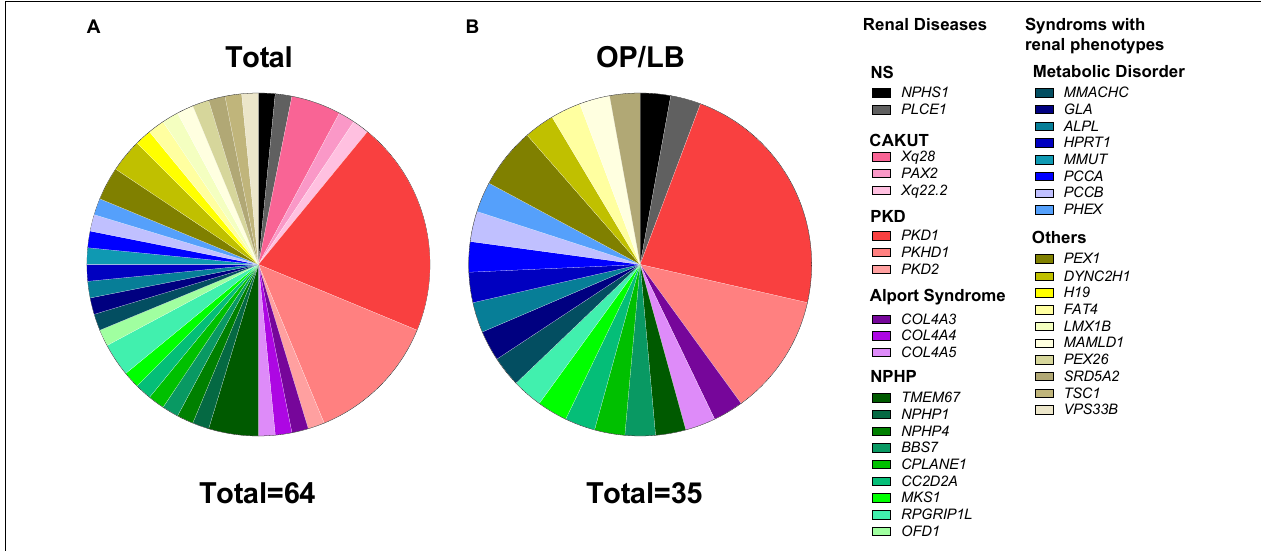
FIGURE 3 | Proportion of cases with diagnosis of pathogenic/likely pathogenic variants in genetic kidney disease. (A) Genetic spectrum of kidney disease in 64 couples who were diagnosed with pathogenic/likely pathogenic variants of known disease causative genes for kidney disease or the syndromes with distinct renal phenotypes. (B) The gene distribution of 35 couples with ongoing pregnancy/live birth (OP/LB) by the end of 2021. CAKUT, congenital anomalies of the kidney and the urinary tract; NPHP, nephronophthisis; NS, nephrotic syndrome; PKD, polycystic kidney disease.